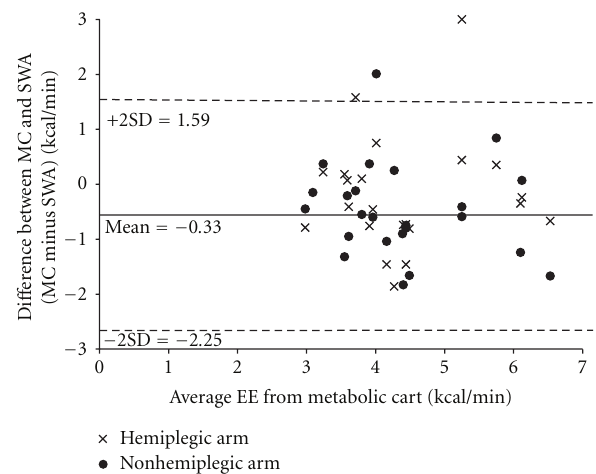
Figure 1: Graphical plot of average EE versus the di ff erence between the two measurement